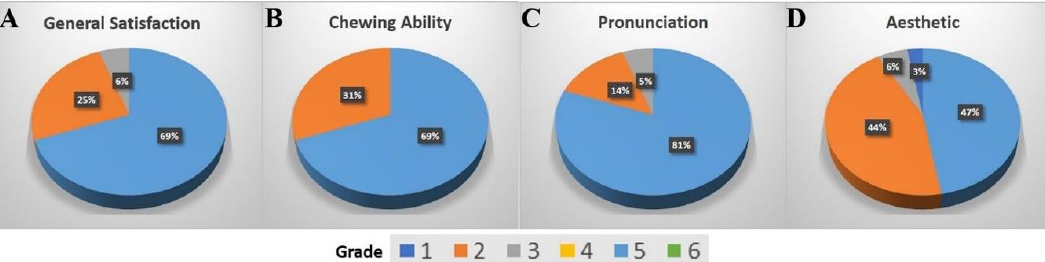
Figure 4. Satisfaction parameters of patients at the follow-up time graded using the German school grading system, in which 1 is the best and 6 is the worst. Left to right: ( A ) general satisfaction, ( B ) chewing ability, ( C ) pronunciation, and ( D ) aesthetics of patient ( n = 36).